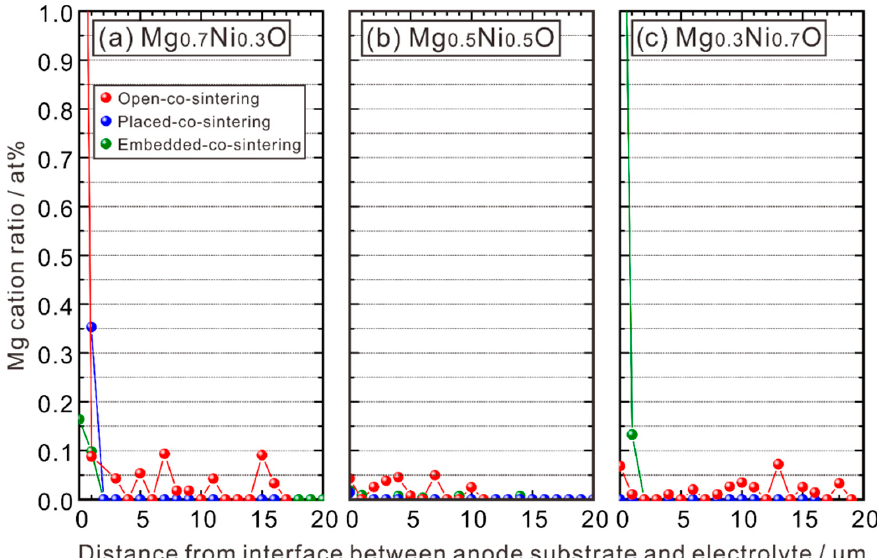
Figure 3. Mg cation ratio in the electrolyte layer of the half cells with the anode substrates of ( a ) BZY20-50 wt % Mg 0.7 Ni 0.3 O, ( b ) BZY20-50 wt % Mg 0.5 Ni 0.5 O, and ( c ) BZY20-50 wt % Mg 0.3 Ni 0.7 O. All